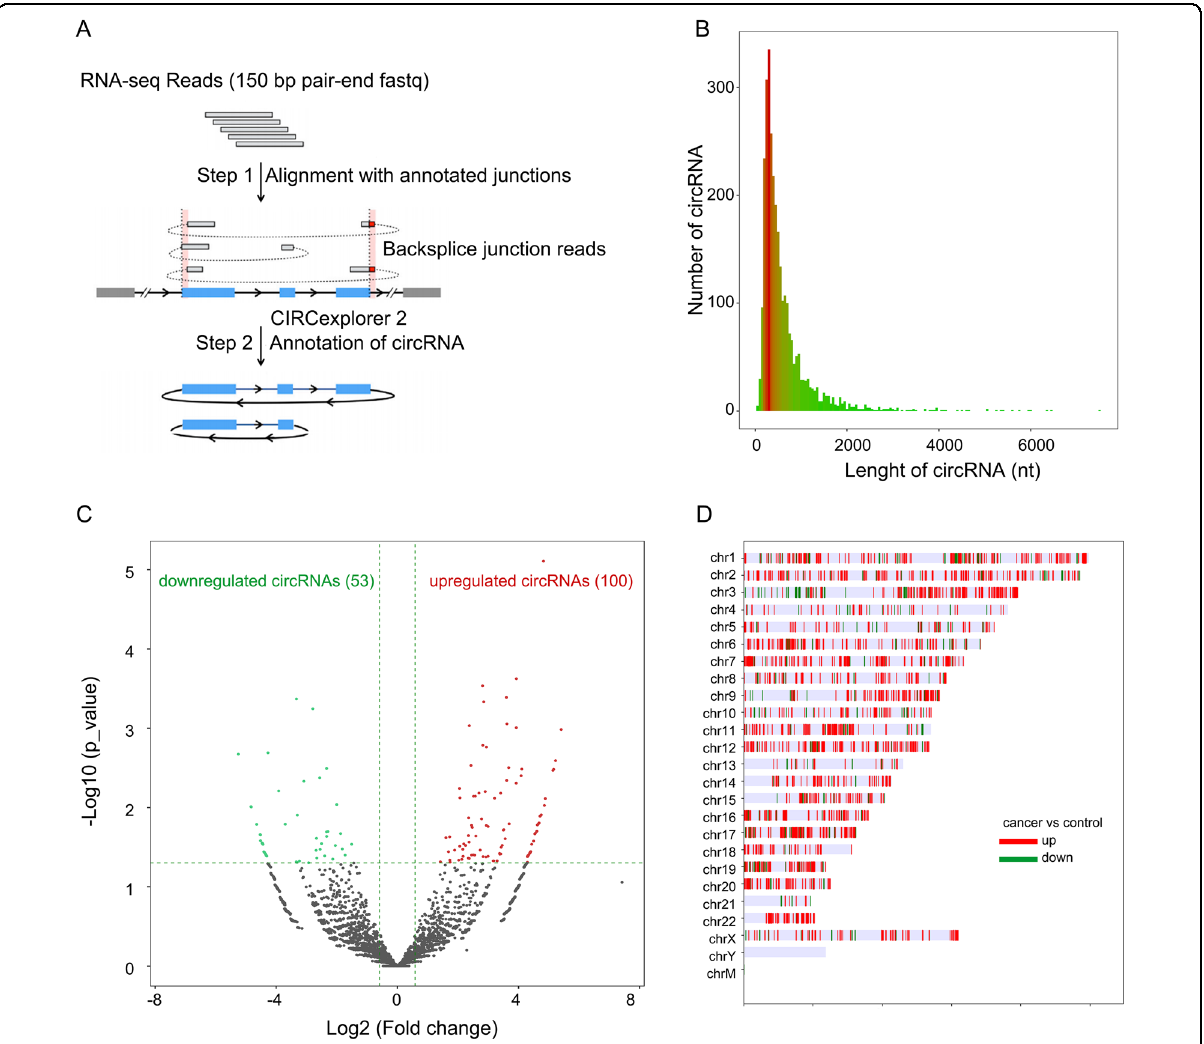
Fig. 1 RNA sequencing reveals the dysregulated circRNAs in HPSCC. A Flowchart illustrating the RNA sequencing and circRNA annotation. B circRNAs length distribution. C Volcano plot showed the downregulated circRNA and upregulated circRNA. D Downregulated and upregulated circRNA distribution in chromosome. chM chromosome